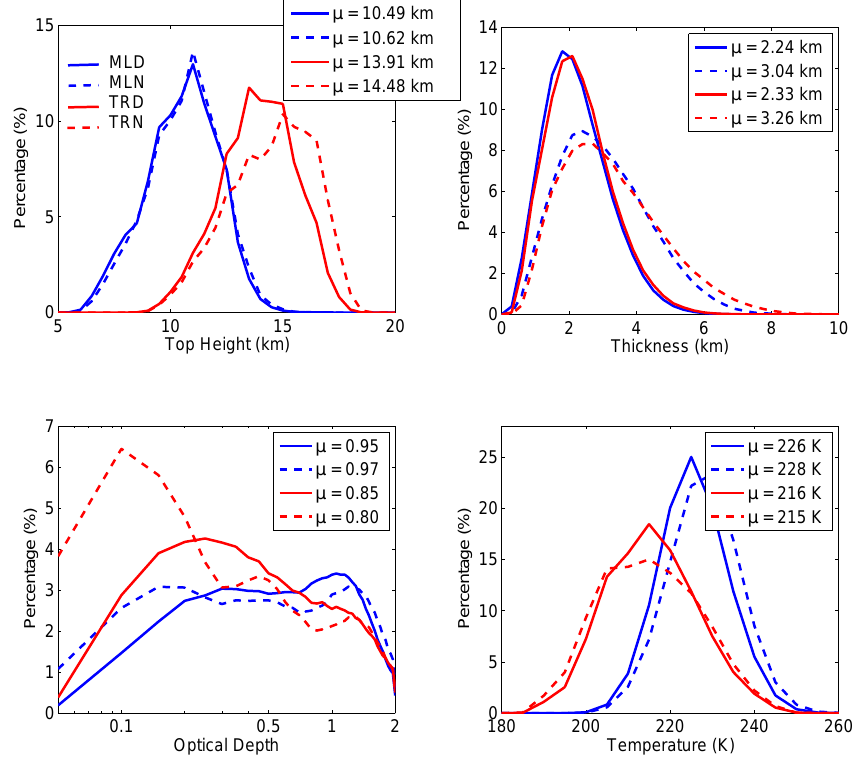
Fig. 3. Same as in Fig. 1 but for geometrically homogeneous cirrus clouds (the Final Database).